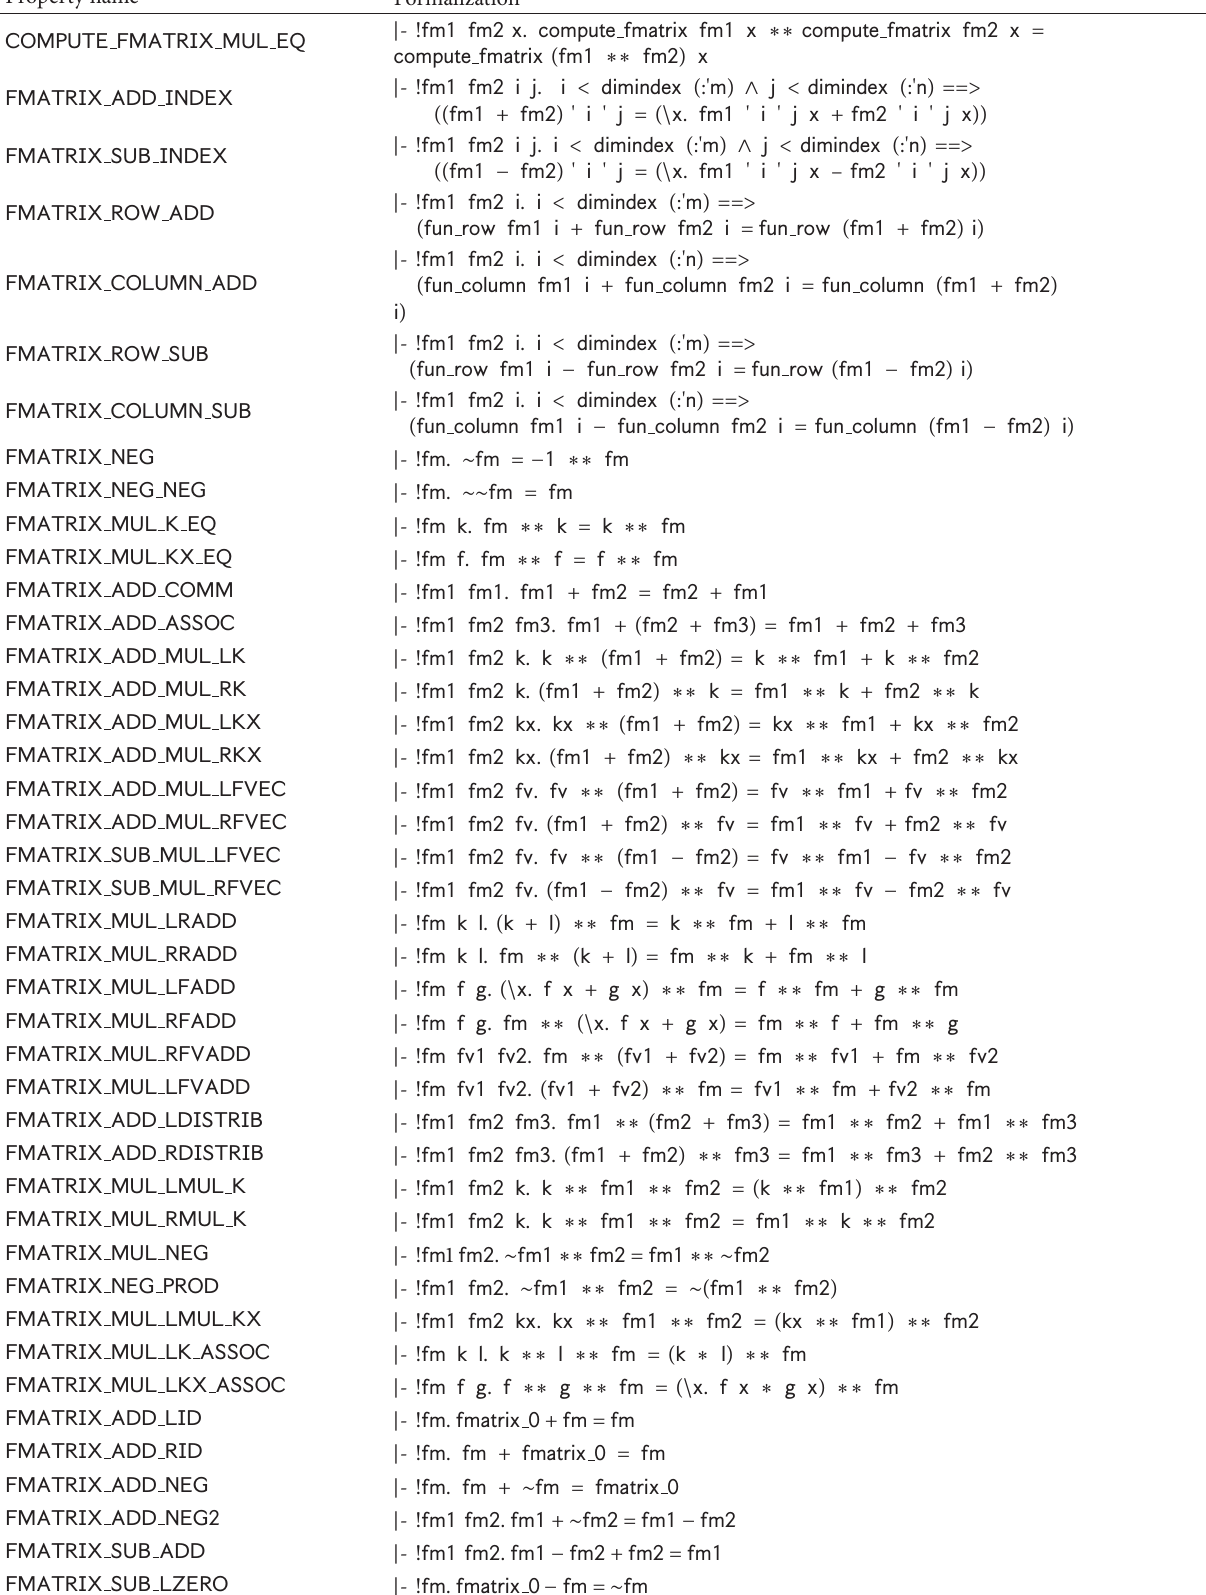
Table 2: Properties of operations of function